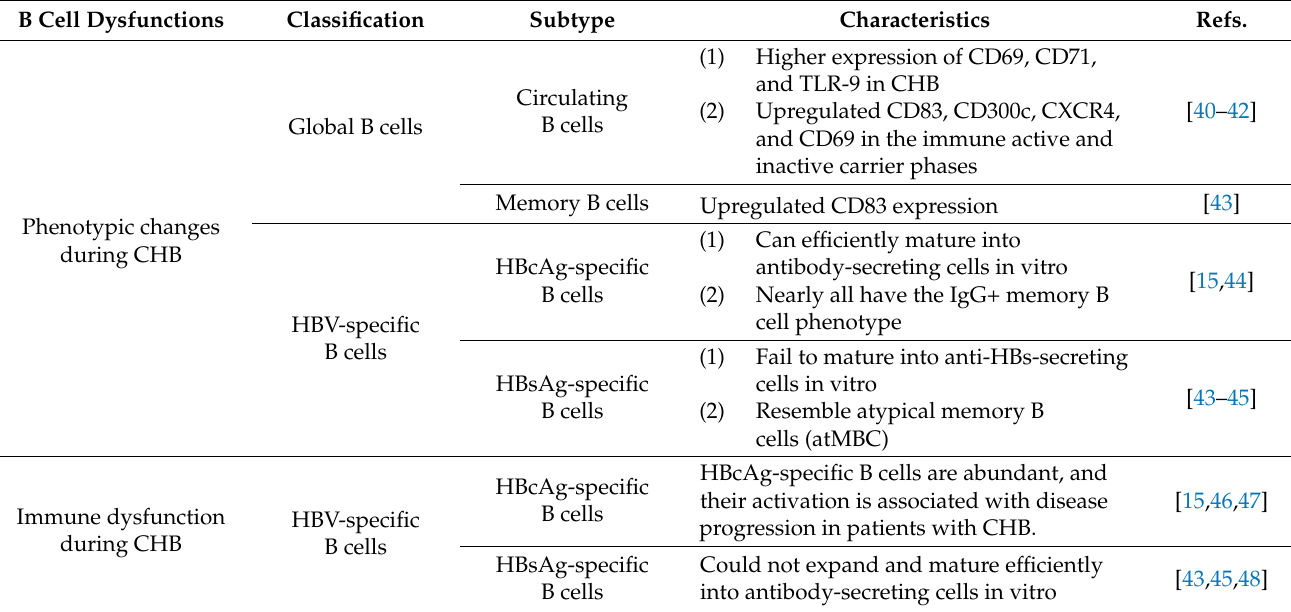
Table 2. Immune dysfunction of B cells during chronic hepatitis B